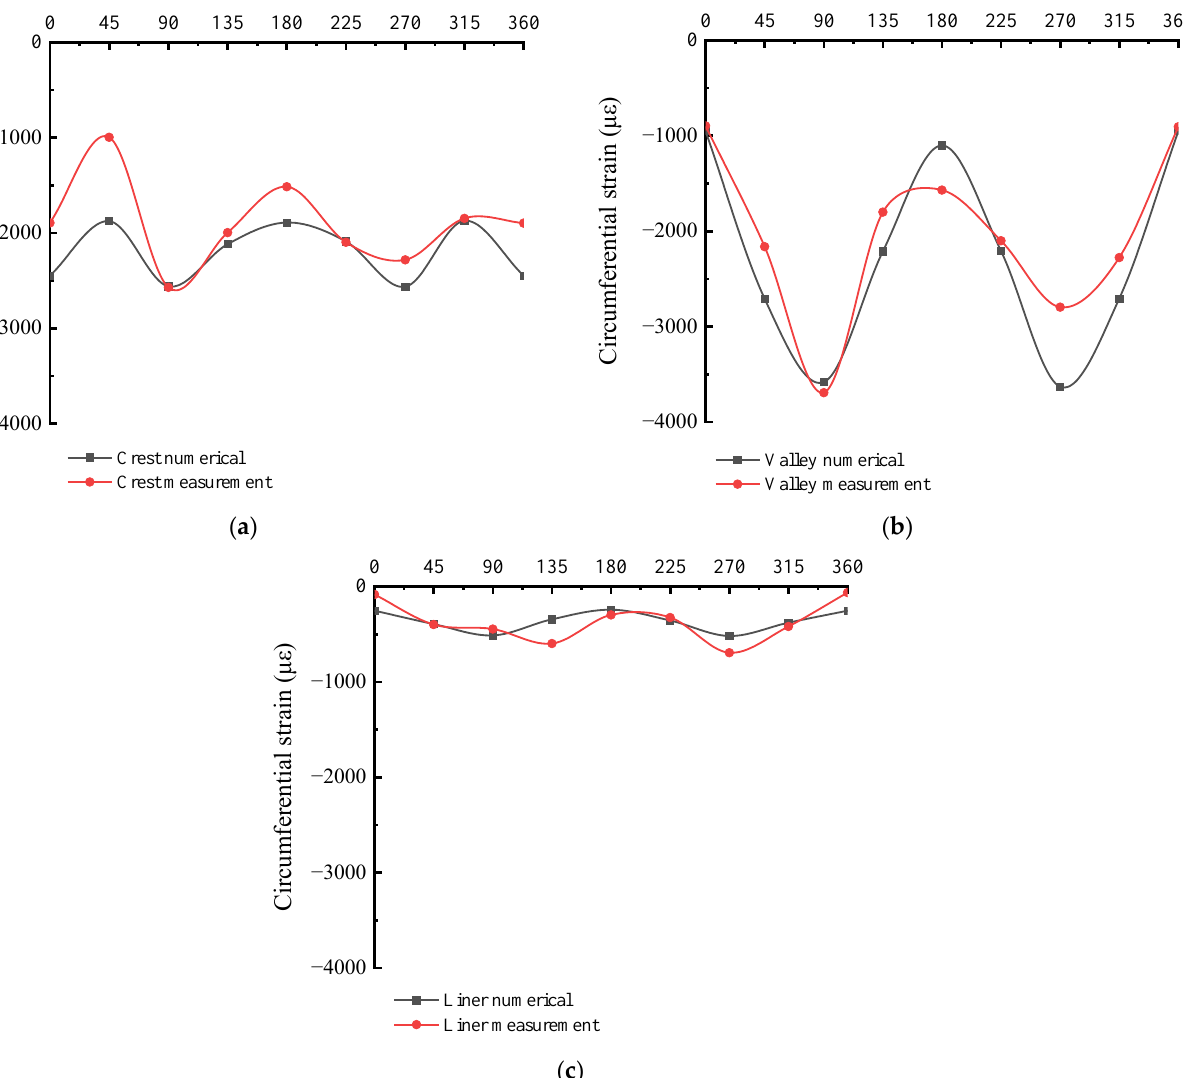
Figure 11. Circumferential strain of pipes. ( a ) Crest; ( b ) Valley; ( c ) Liner.